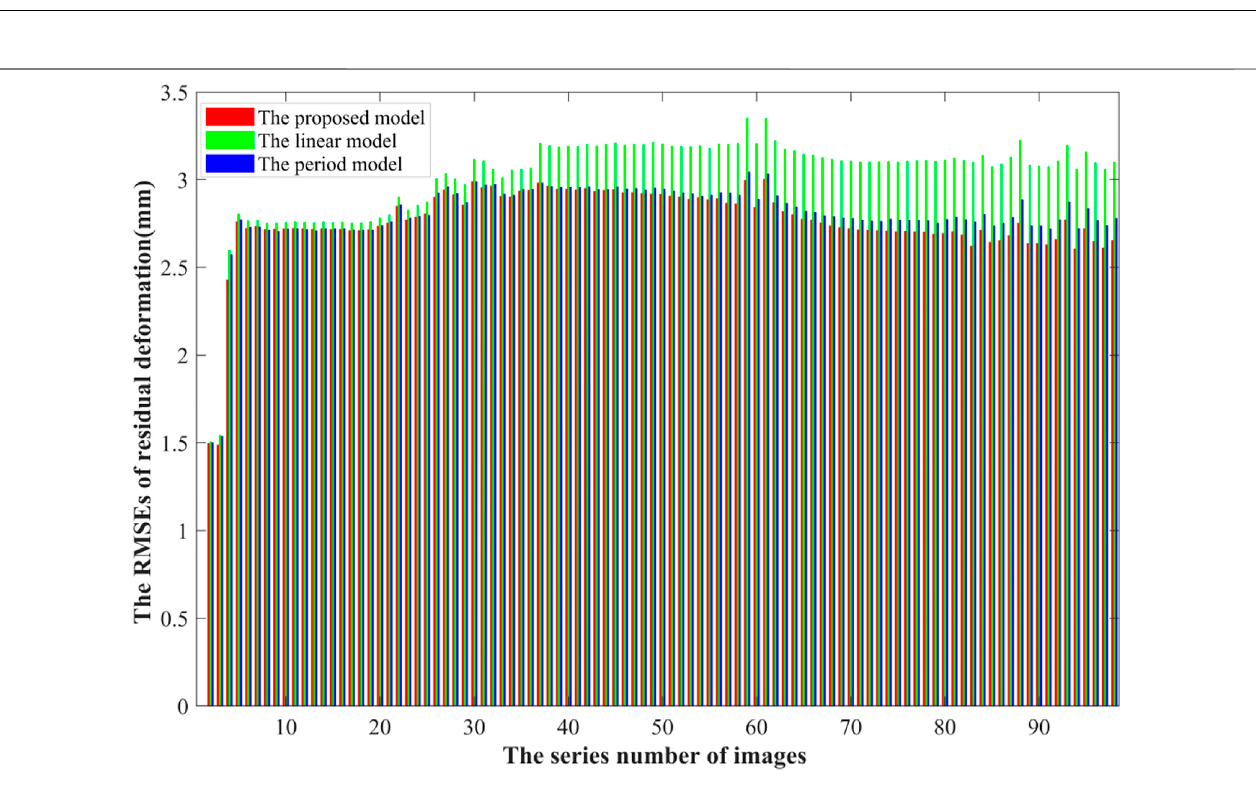
FIGURE 7 | of the residual deformations of the 98 SAR images.